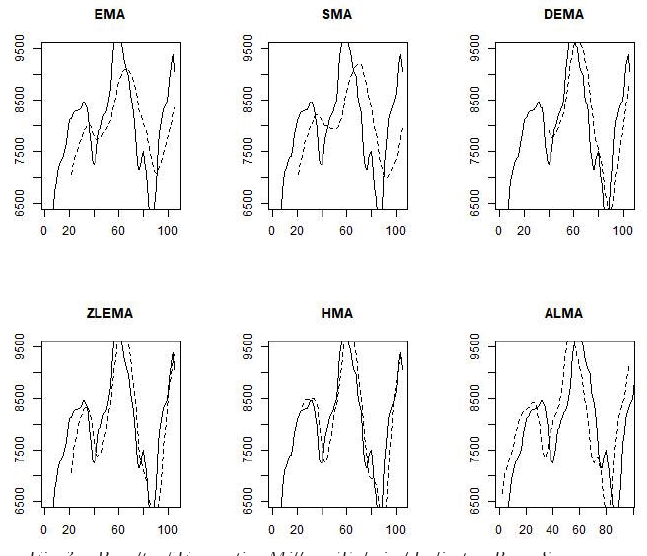
Fig. 3 – Results of Forecasting Milk on Technical Indicators Base. Source: own Parameters of the individual models, which are best suited for the given commodity or the degree of accuracy, are presented in Table 4. The computational procedure of the optimized parameters was performed according to the syntax in the R language mentioned previously. Tab. 4 – Optimized Period of Technical Indicators. Source: